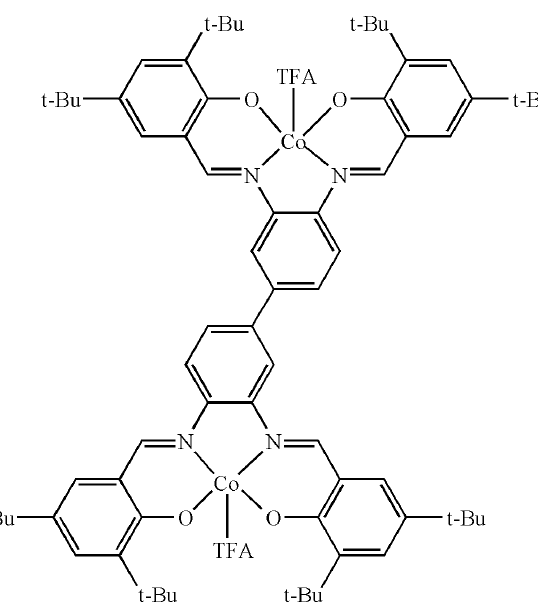
Figure 3. Calculation model of (salen- 4 )[Co(III)TFA] 2 .